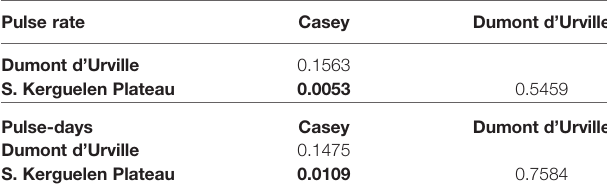
TABLE 4 | Kruskal-Wallis and post hoc Dunn test comparisons for differences in pulse rates per year (KW Chi-squared=8.53, df = 2 and p = 0.01) and